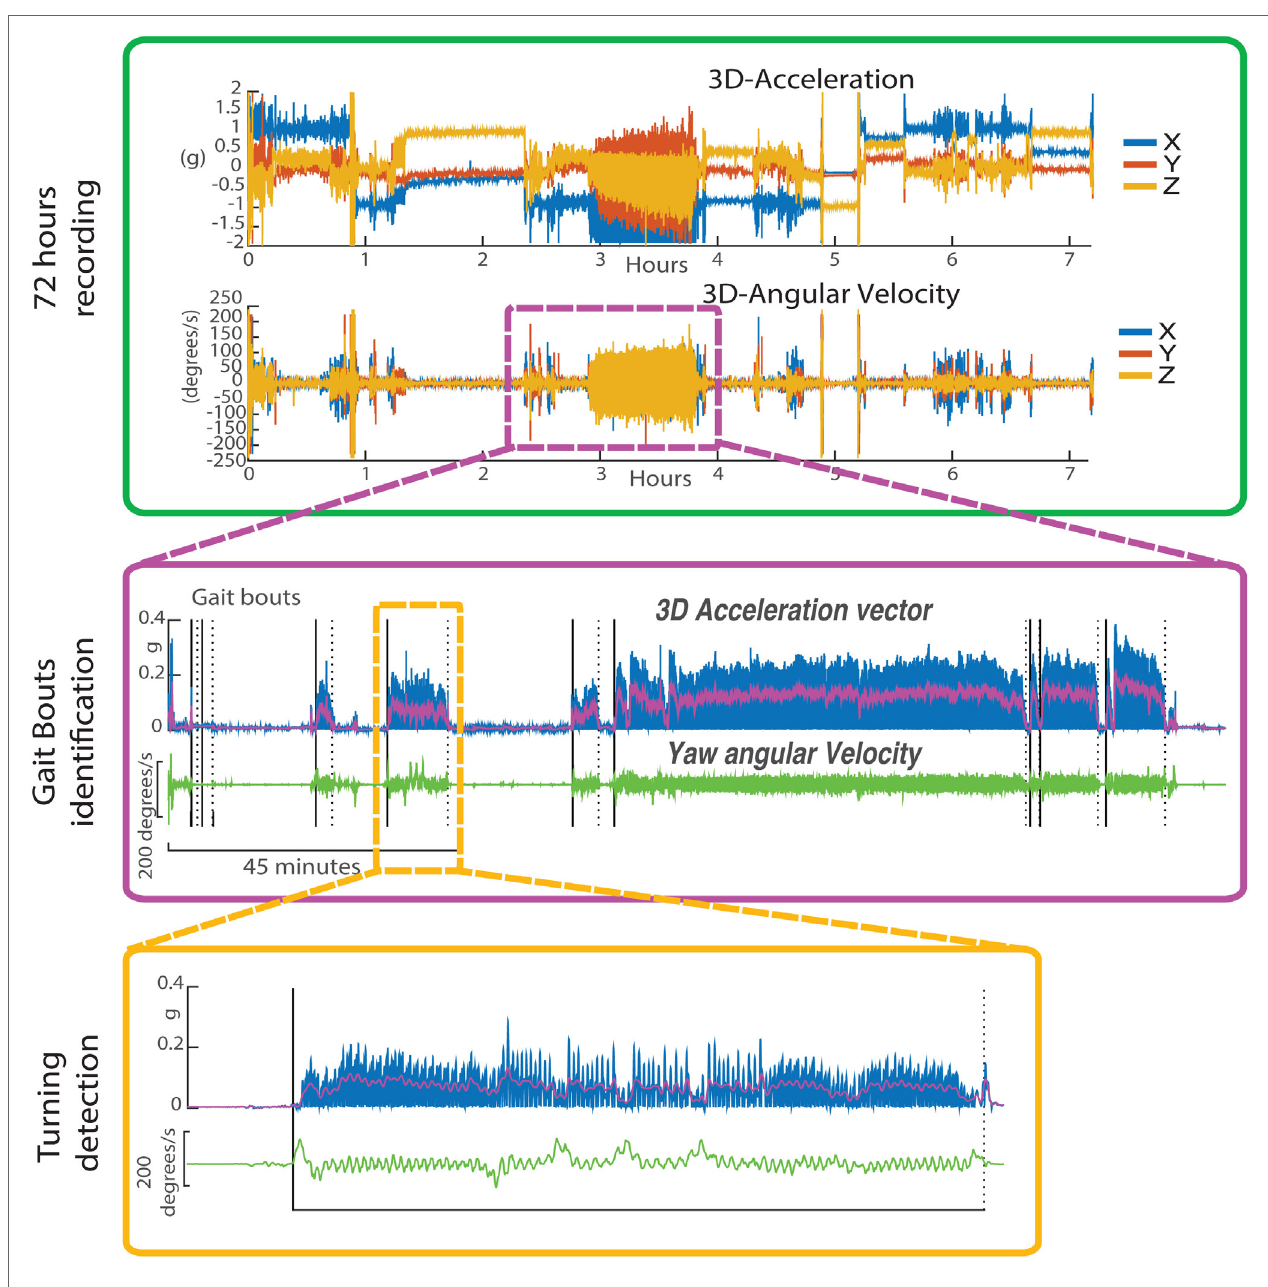
FigUre 1 | Profile of the inertial sensor data worn on the waist for 72 h. Upper panel: 3D acceleration and 3D angular velocity from continuous monitoring over 7 h. Middle panel: details on gait bouts identification. Lower panel: detailed profile on the Yaw angular velocity during a single gait